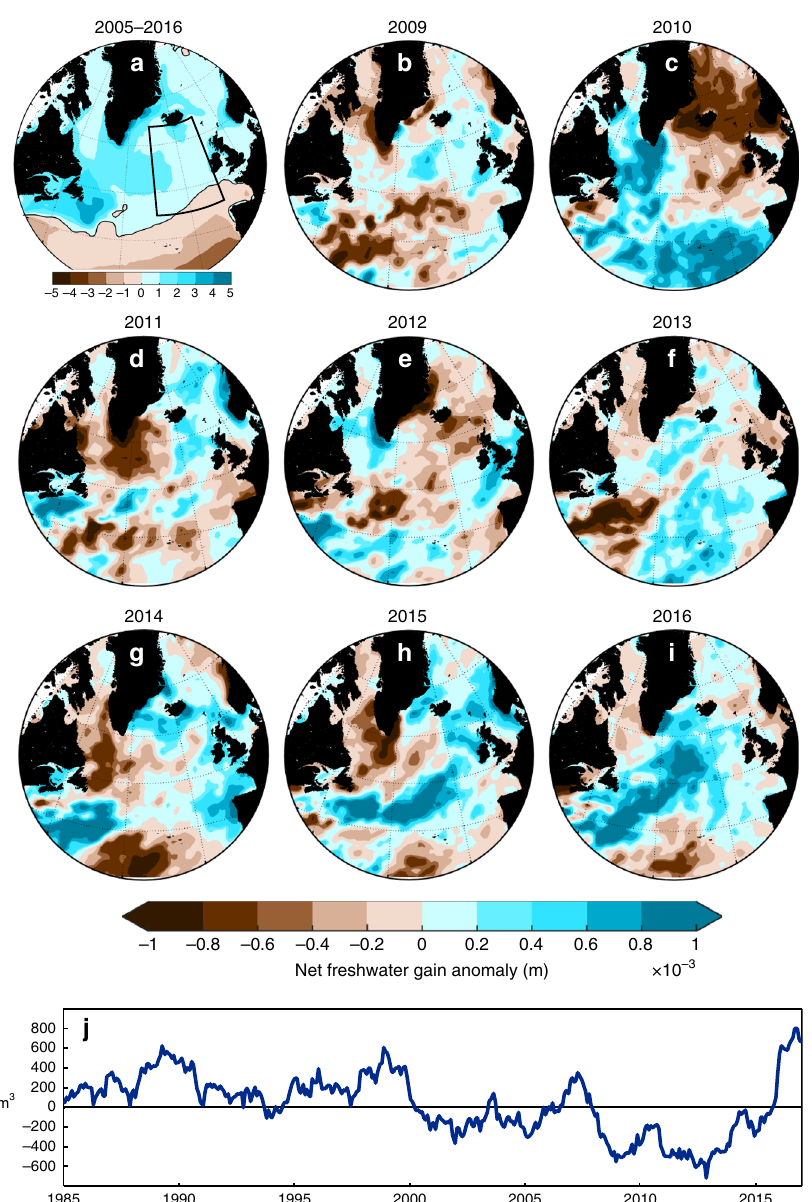
Fig. 7 Freshwater input from the atmosphere. a 2005 – 2016 mean net freshwater gain by the ocean (precipitation minus evaporation) from ERA-Interim dataset. b – i 2009 – 2016 annual anomalies referenced to the mean j a 5-year moving sum of monthly net precipitation anomalies (from 1981-2010 mean) integrated over the region 45 – 65°N, 30 – 10°W (box outlined in a